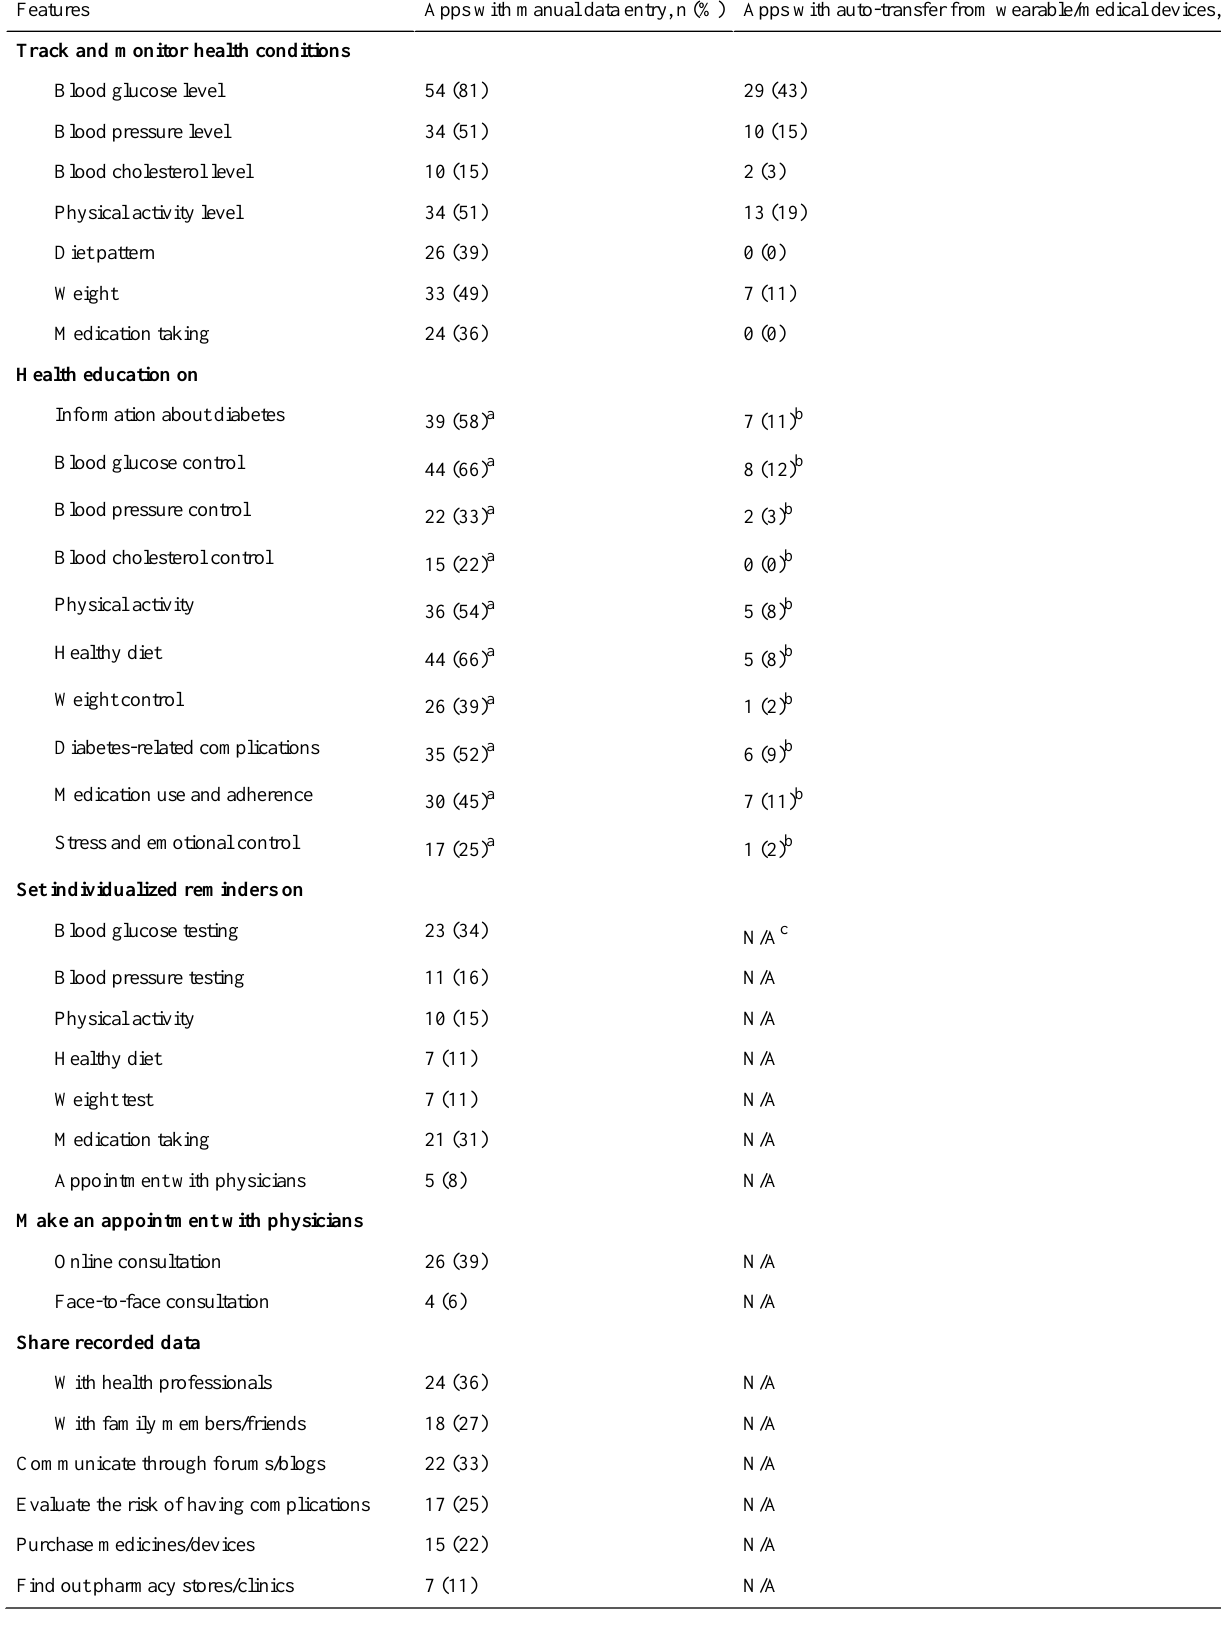
Table 2. Features to support diabetes